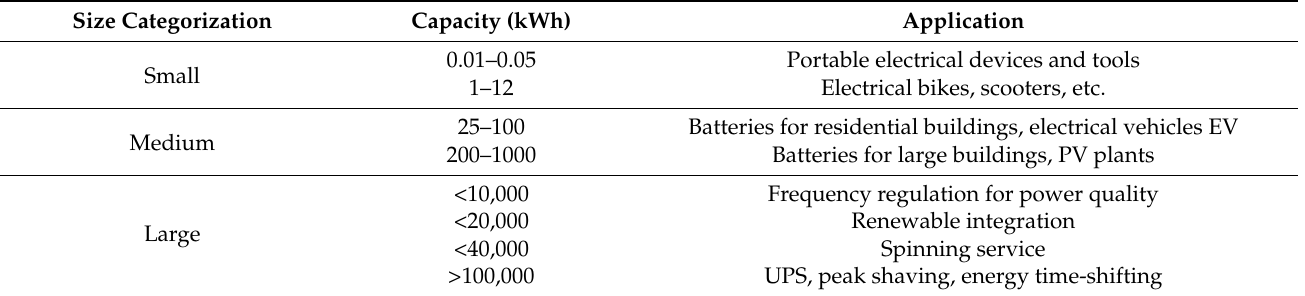
Table 6. Basic classification of batteries [32,112,120–123].